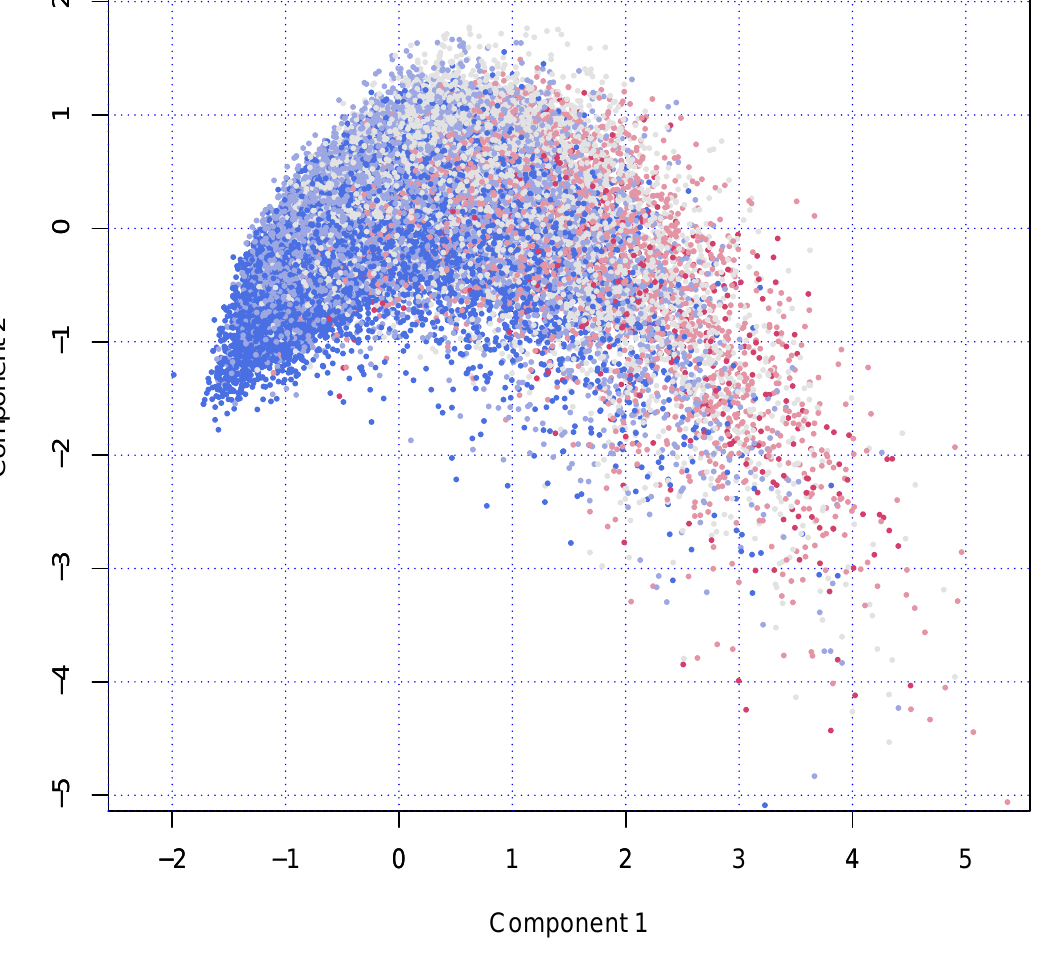
The “nozzle” located